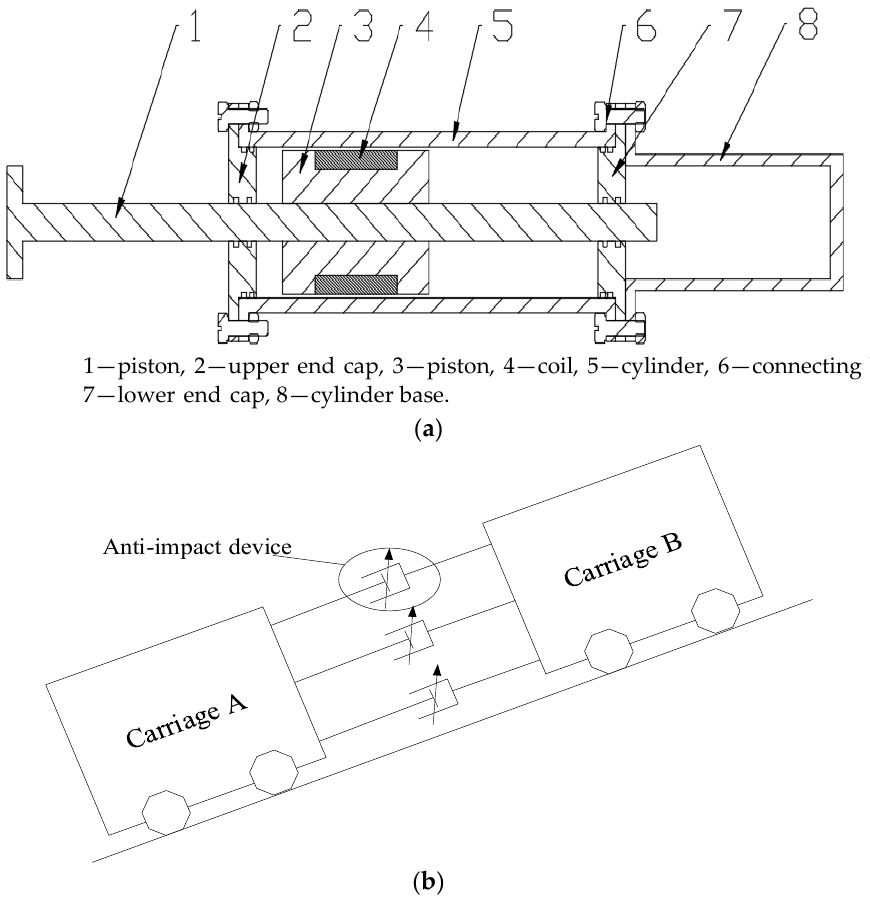
Figure 1. Schematic diagram of structure and installation of double-rod magnetorheological damper. ( a ) Structure schematic diagram of a double-bar magnetorheological damper; ( b ) installation diagram of anti-impact device.